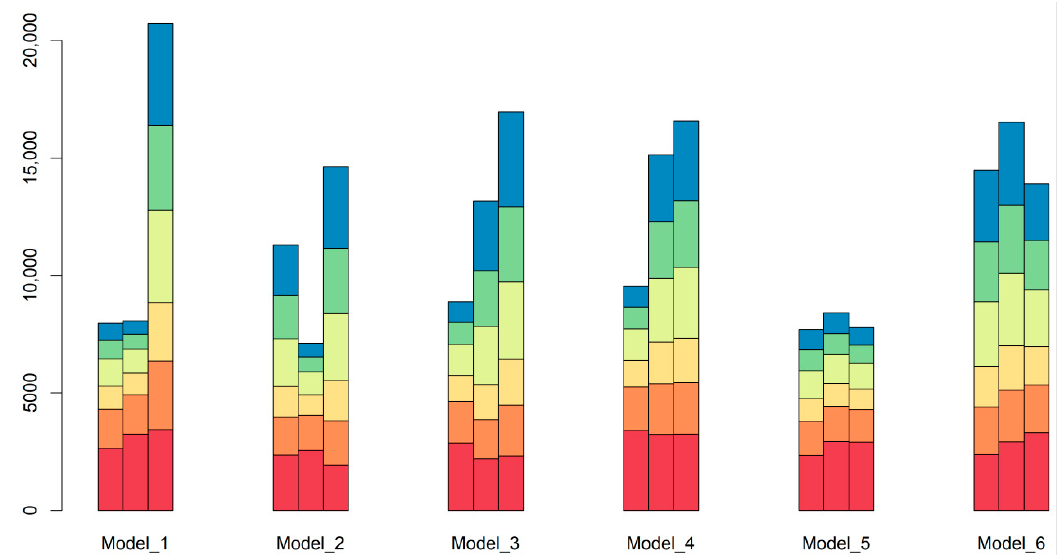
Figure 10. Return levels of flood events for all six models (Table 2) and all three scenarios. For each model there are three columns representing the historical (left), the RCP4.5 (middle), and the RCP8.5 scenario values. The discharge at the outlet for a 2-year, 5-year, 10-year, 25-year, 50-year, and 100-year event are indicated according to the generalized extreme value (GEV) model and the generalized maximum likelihood estimation (GMLE) method.